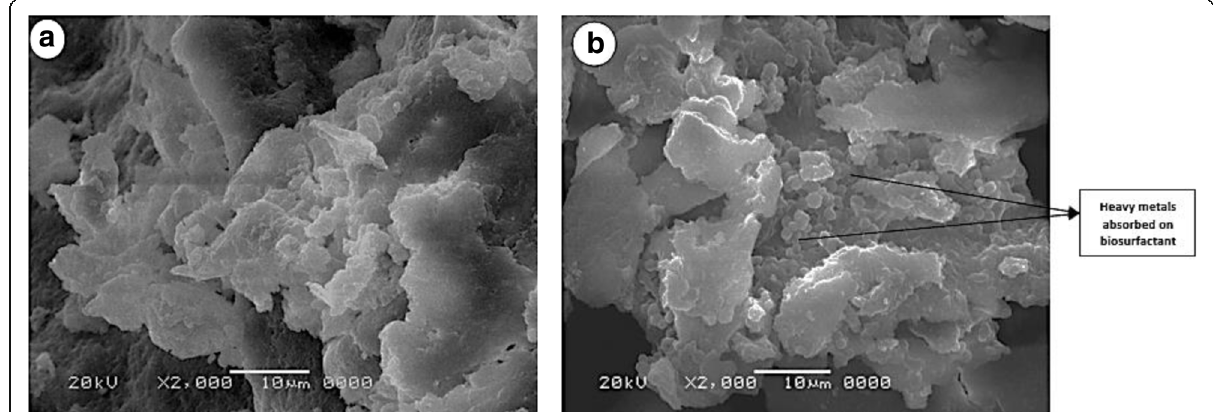
Fig. 8 SEM images of a native biosurfactant and b biosurfactant interacted with